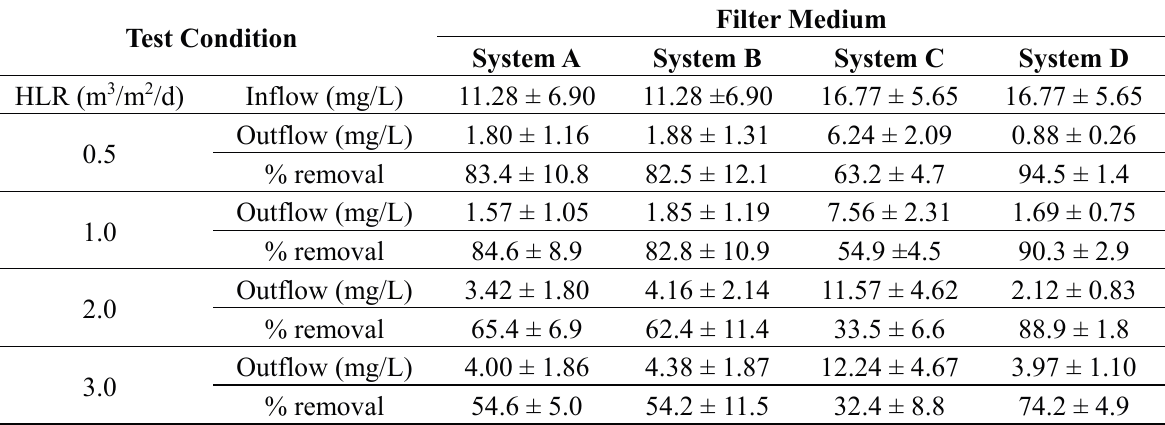
Table 2. SS removal performance under different HLR